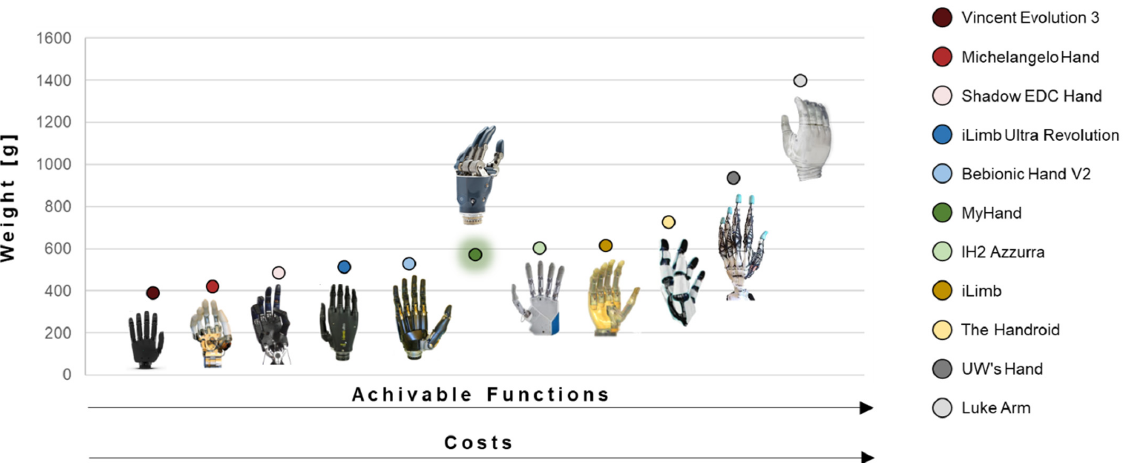
Figure 1. Comparison between weights of eleven anthropomorphic prosthetic hands. On the horizontal axis, the achievable functions and device costs increase from the left to the right. The MyHand prosthesis is highlighted with a green aura.